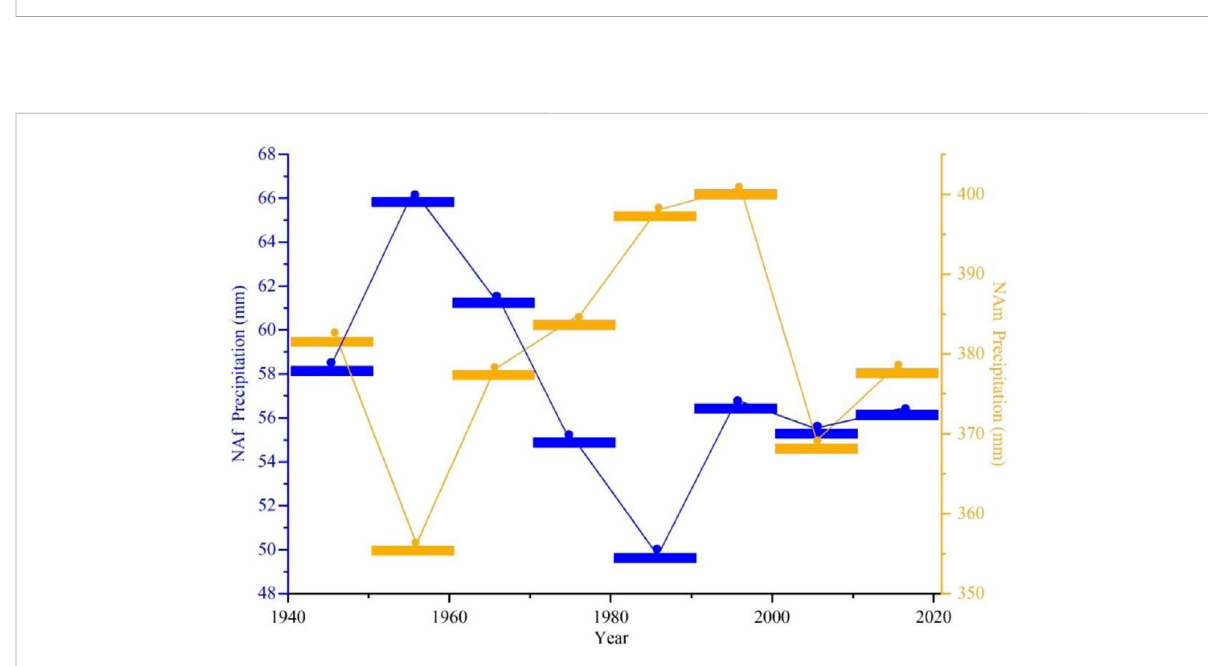
FIGURE 4 Interdecadal precipitation variations in the NAm and NAf from 1941 to